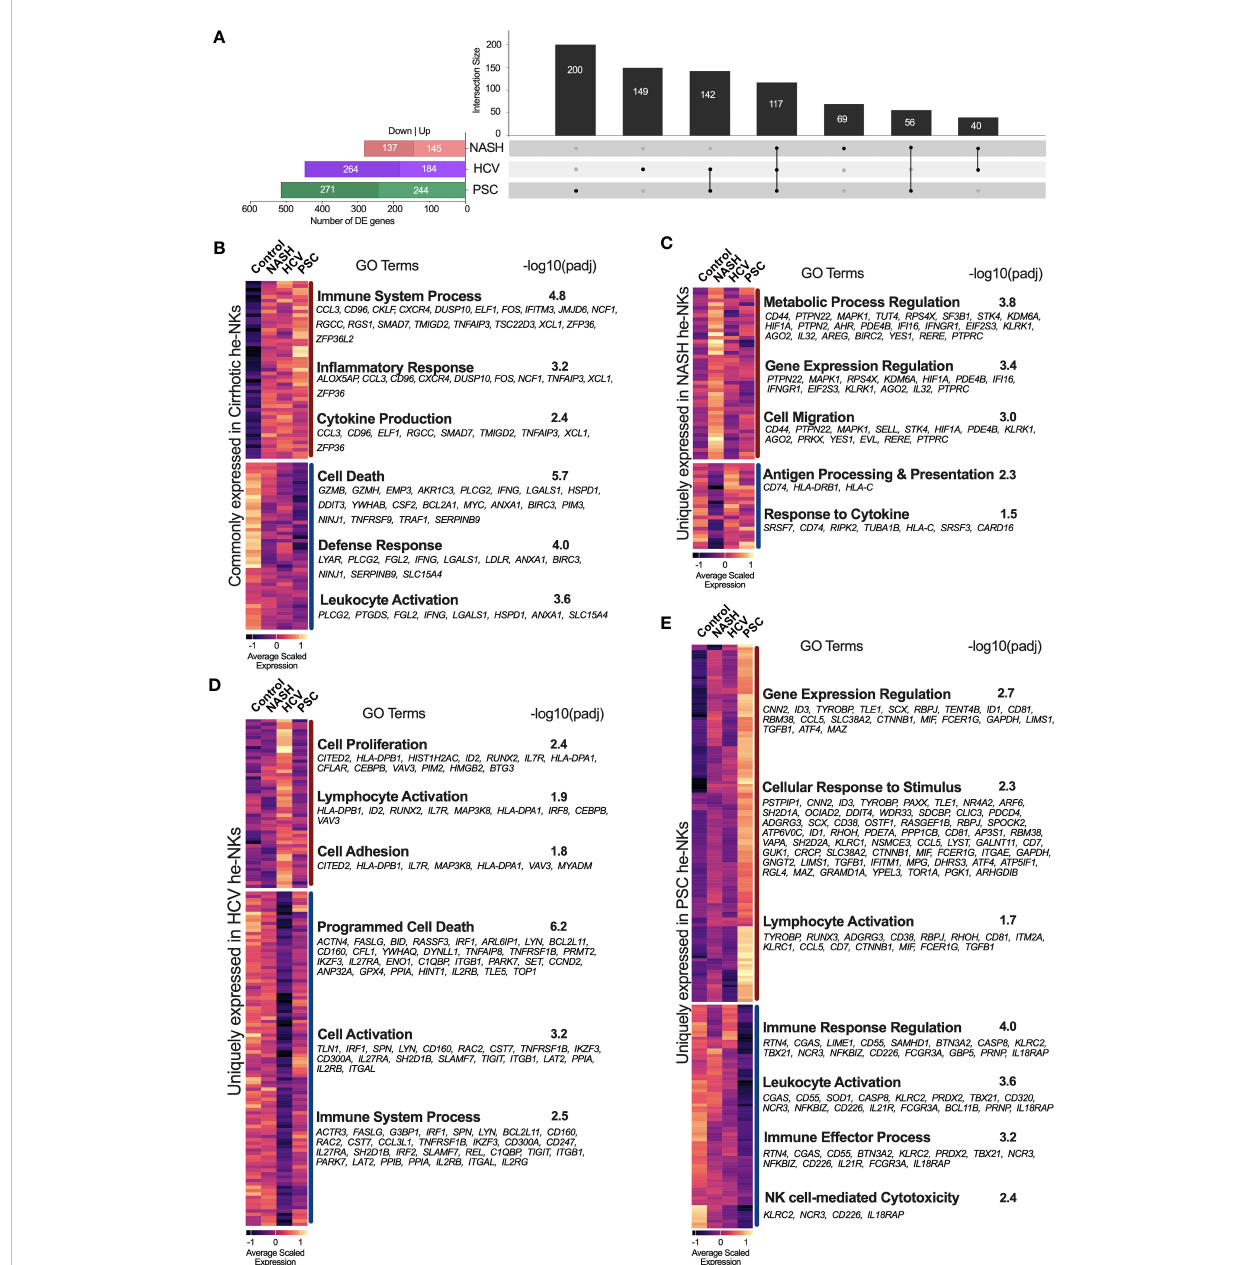
FIGURE 2 Transcriptional fi ngerprints of He-NK from end-stage chronic liver diseases. (A) Left bars show the total number of differentially expressed genes (DEGs) found in each disease group. Black columns show the intersection of DEGs among He-NKs from cirrhotic livers. We observed that a total of 117